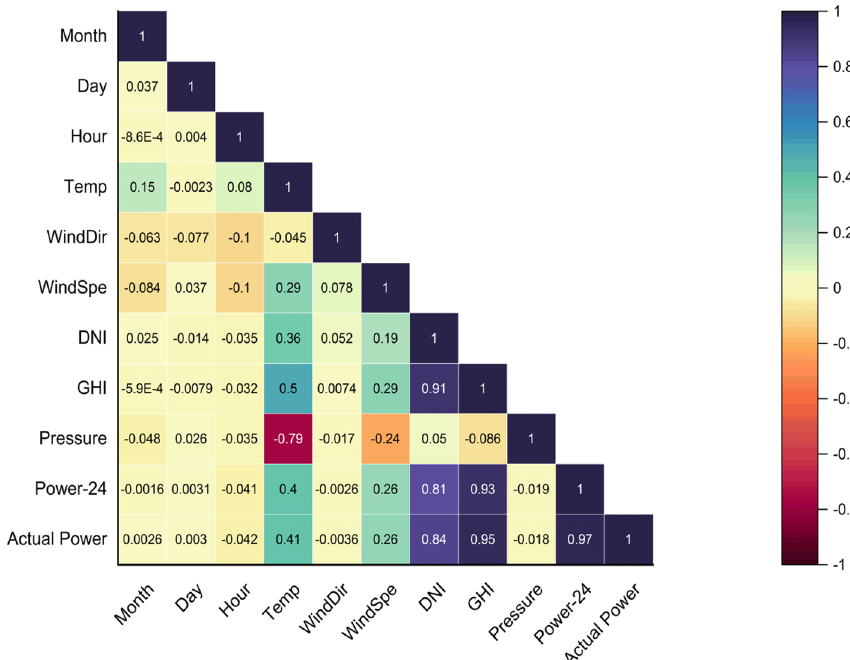
Fig. 3 Correlation coefficients results between the input features and the PV power